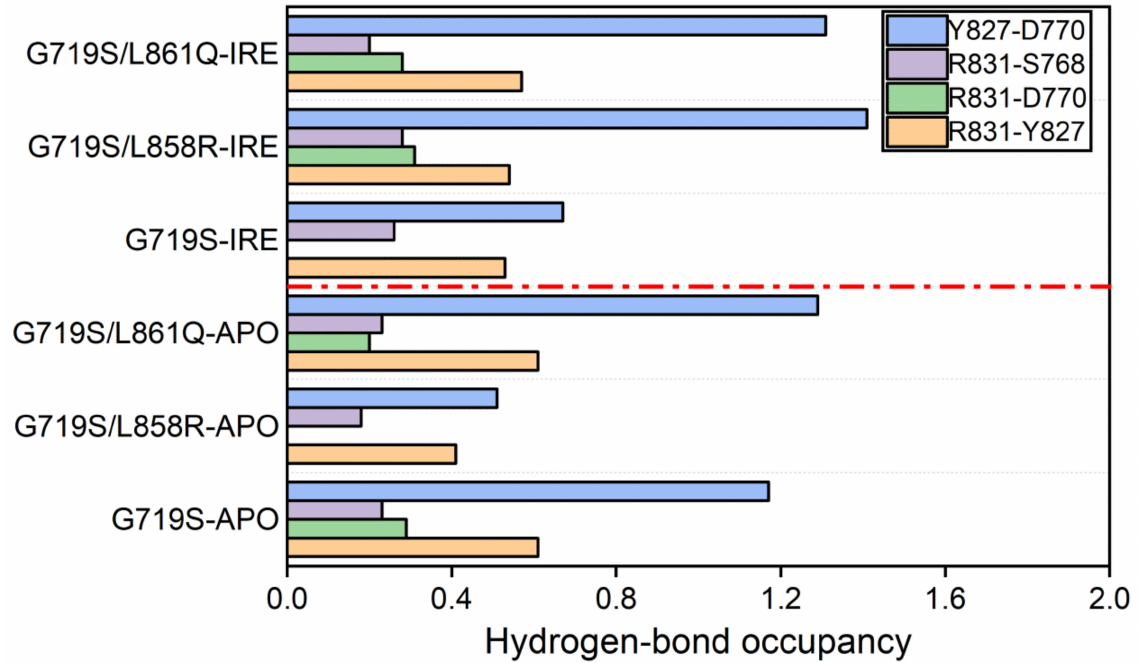
Figure 6. Hydrogen bond occupancy differs between the APO systems and the complex systems. Some residues have a hydrogen bond donor or acceptor of more than one, thus the hydrogen bond occupancy is above 1. A low panel of the red dotted line indicates the occupancy of hydrogen bonds (Y827-D770, R831-S768, R831-D770, and R831-Y827) in the APO systems, and the top panel indicates the occupancy of these hydrogen bonds in the complex